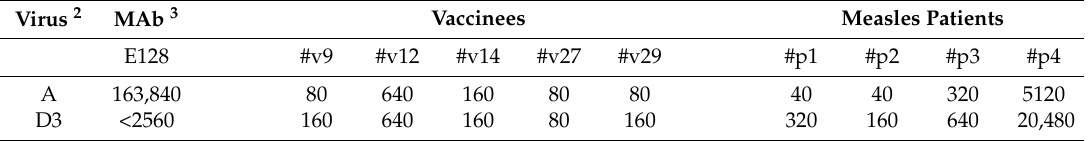
Table 3. Neutralizing titers of human sera from five vaccine recipients and four measles patients 1 .